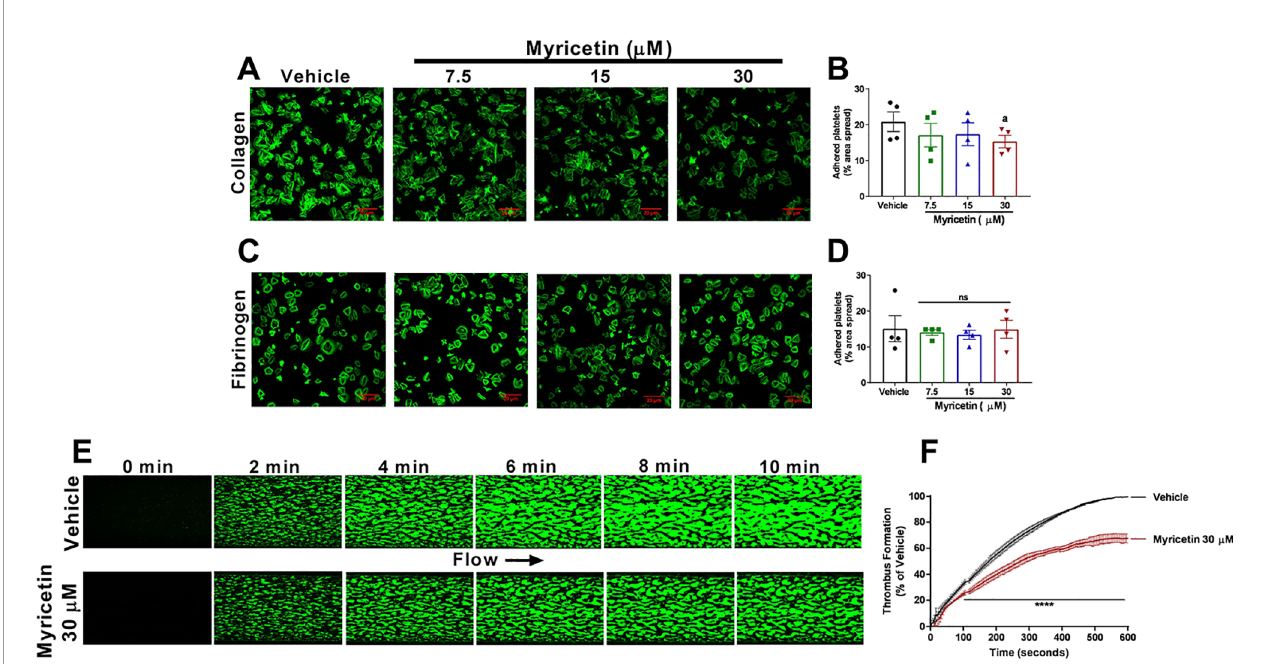
FIGURE 4 | Myricetin inhibits adhesion to collagen and thrombus formation in vitro . Washed platelets (WP) were pre-treated with myricetin (7.5, 15, and 30 mM) for 10 min and left to adhere to coverslips coated with 100 mg/ml of collagen (A , B) or fi brinogen (C , D) for 45 min. Platelets were stained with Alexa Fluor 488 or 647- conjugated phalloidin for visualization. DioC6-labeled whole blood was pre-treated with myricetin (30 mM) or vehicle control and blood perfused through collagen- coated Vena8 biochip channels at a shear rate of 45 dyn/cm2 for 10 min. (E) Representative image of thrombus formation assay. (F) Quanti fi cation of fl uorescence normalized by vehicle control. a p < 0.05 vs Vehicle. ****p < 0.001 vs Vehicle. ns, non signi fi cative. For adhesion assay, bar graphs (B , D) represent mean ± SEM and individual data points of four independent experiments. For thrombus formation assay, line graph (F) represent mean ± SEM of three independent